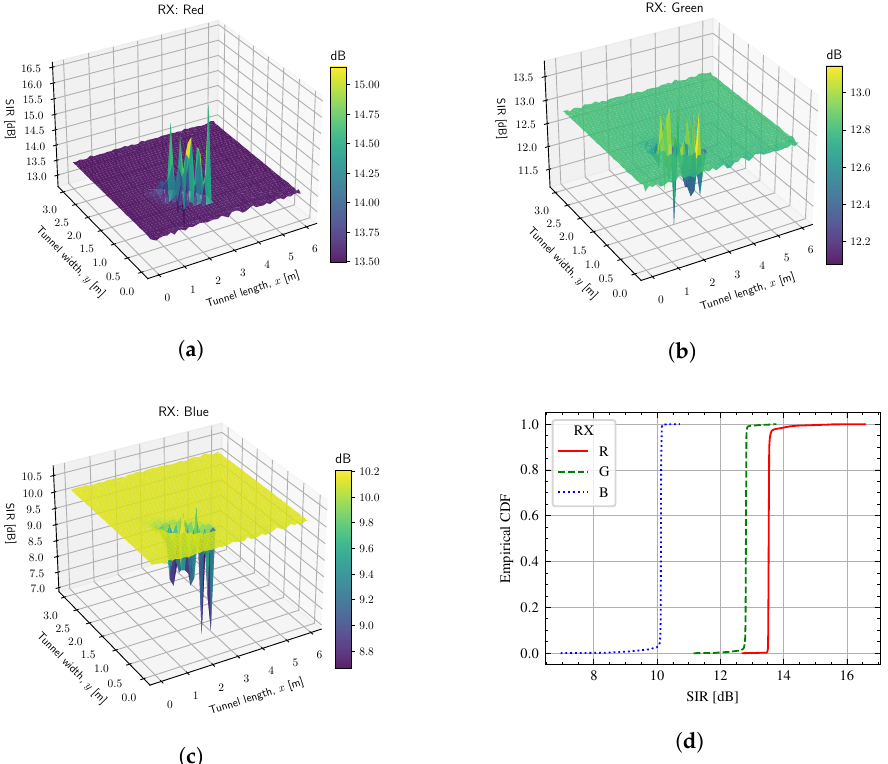
Figure 6. Signal-to-interference ratio. ( a ) Red PD. ( b ) Green PD. ( c ) Blue PD. ( d ) Empirical CDF for SIR at red, green, and blue